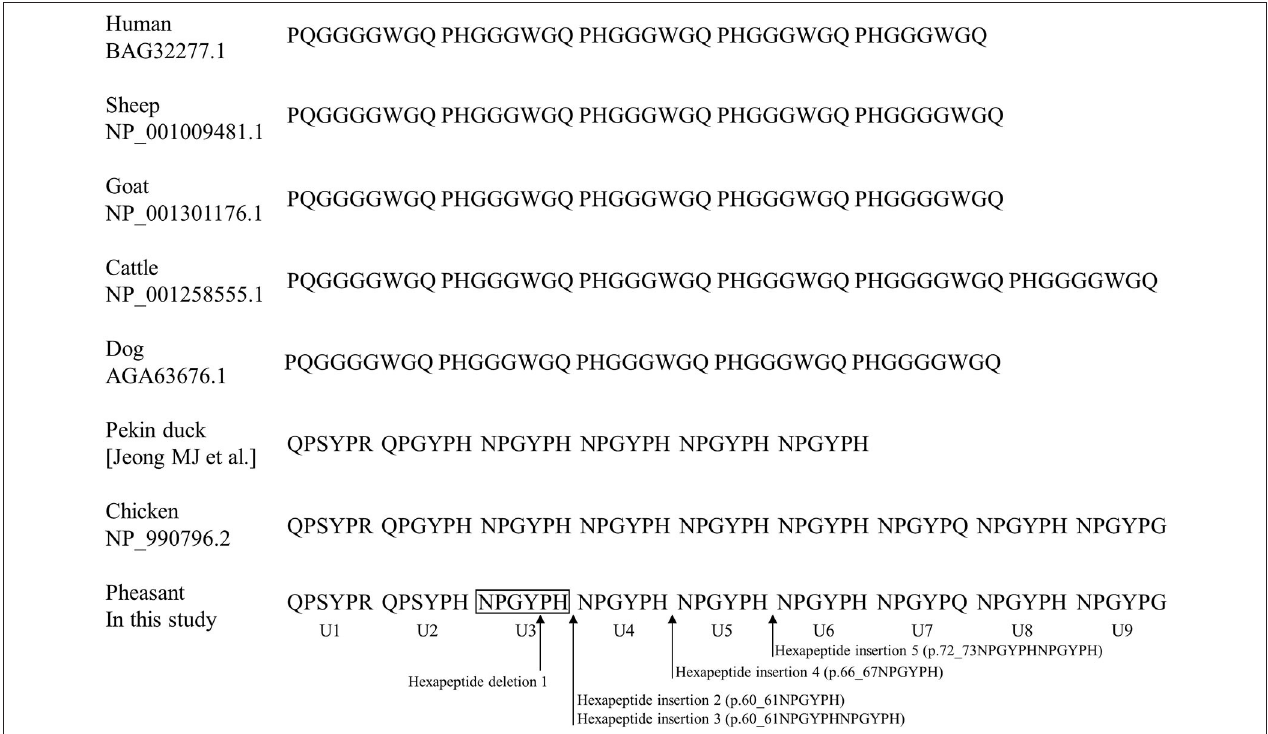
FIGURE 3 | Comparison of tandem repeat sequences in humans, sheep, goats, cattle, dogs, Pekin ducks, chickens and pheasants. The amino acid sequences of the tandem repeat region were obtained from GenBank at the National Center for Biotechnology Information (NCBI), including human (BAG32277.1), sheep (NP_001009481.1), goat (NP_001301176.1), cattle (NP_001258555.1), dog (AGA63676.1), Pekin duck ( 21), chicken (NP_990796.2) and pheasant (In this study). The arrows indicate the insertion/deletion polymorphisms found in this study. U 1-9: hexapeptide repeat